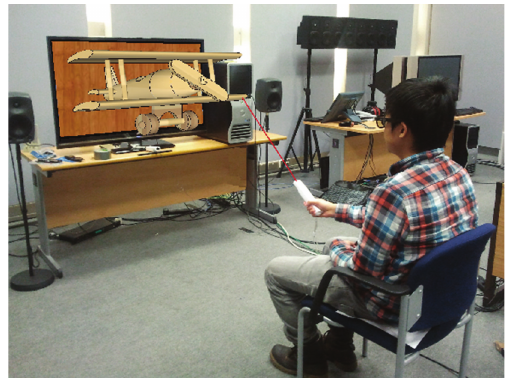
Figure 3: Experimental setup used in the user preference study with Wiimote.